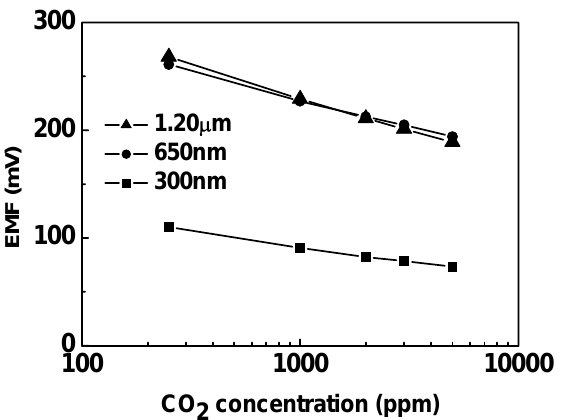
(logPco ) for 300nm, 650nm and 1.2 µ m 2 2